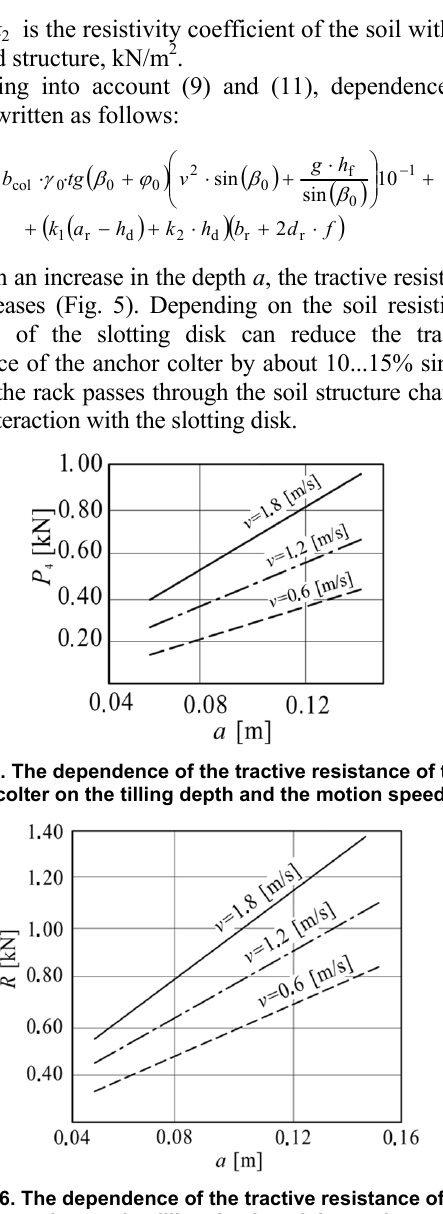
Figure 6. The dependence of the tractive resistance of the sowing section on the tilling depth and the motion speed